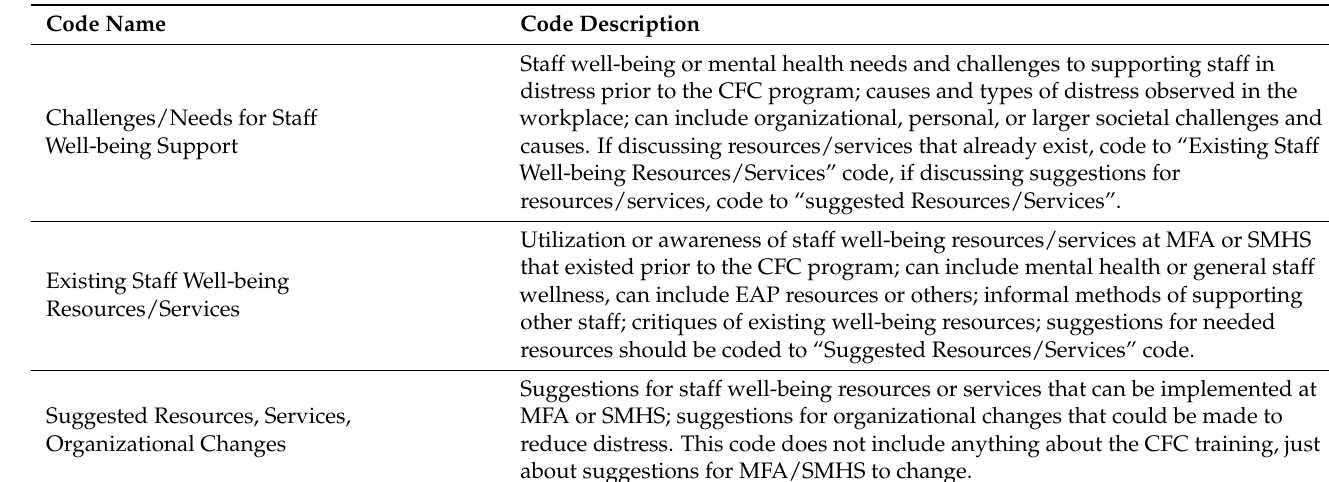
Table 2. Qualitative codes and